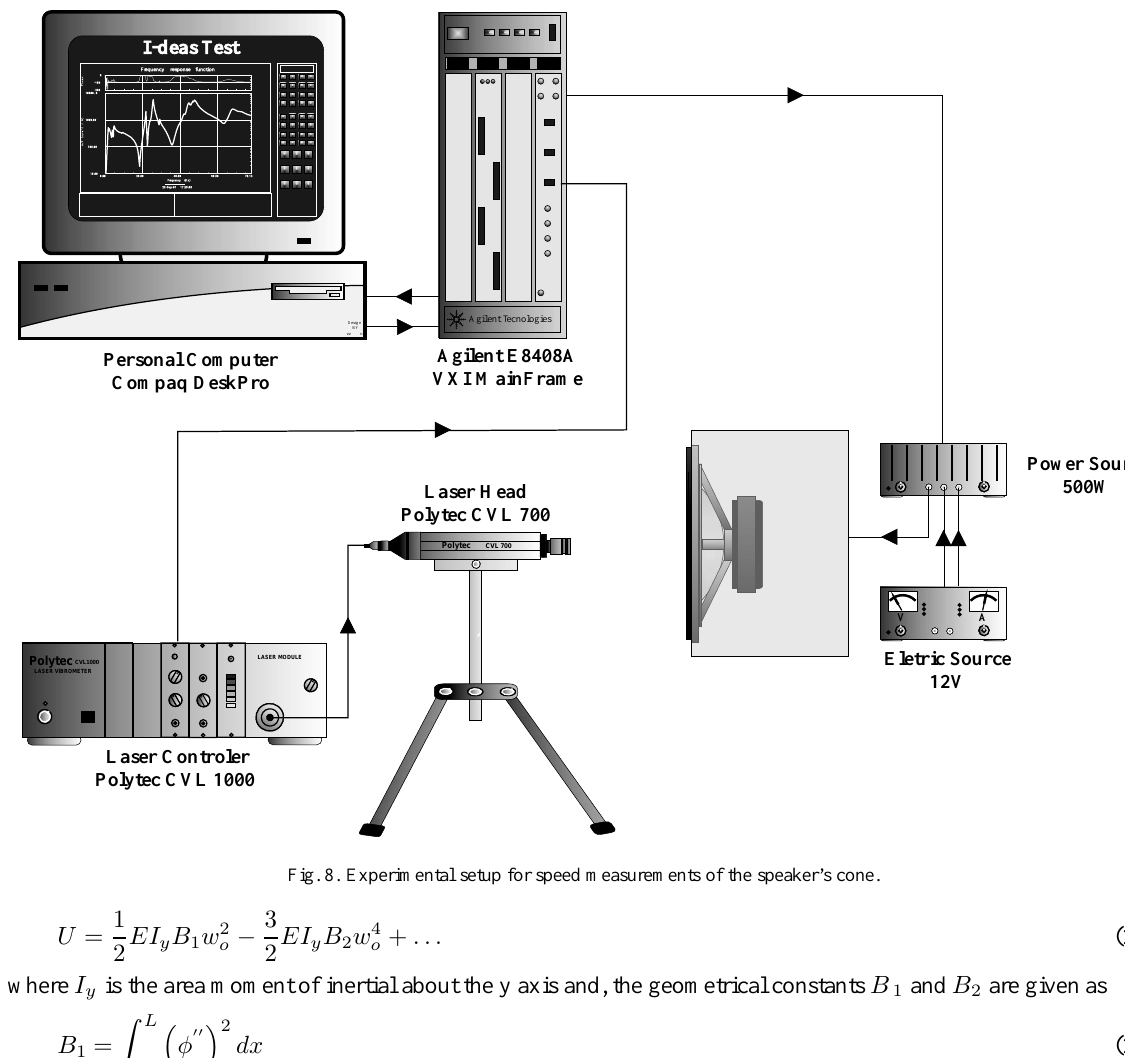
Fig. 8. Experimental setup for speed measurements of the speaker’s